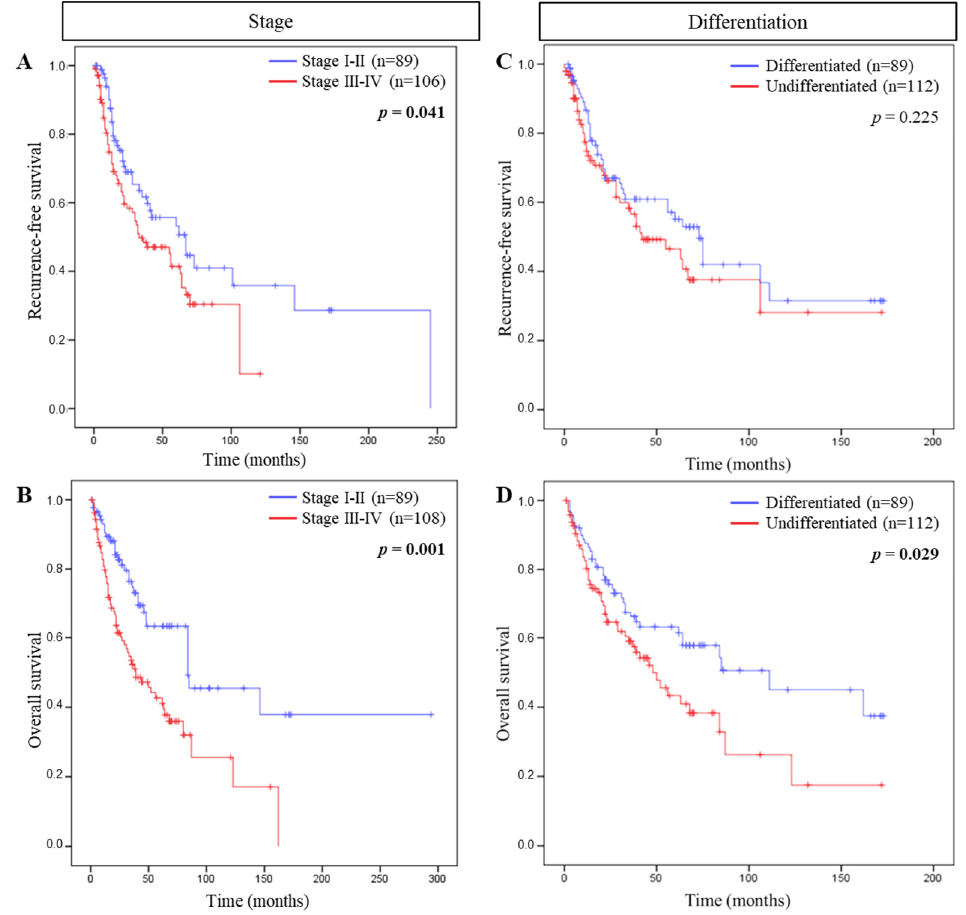
Figure 1. Association between tumor stage and differentiation and patient survival. Kaplan–Meier curves comparing ( A ) recurrence-free survival (RFS) and ( B ) overall survival (OS) of tumor stage and ( C ) RFS and ( D ) OS of tumor